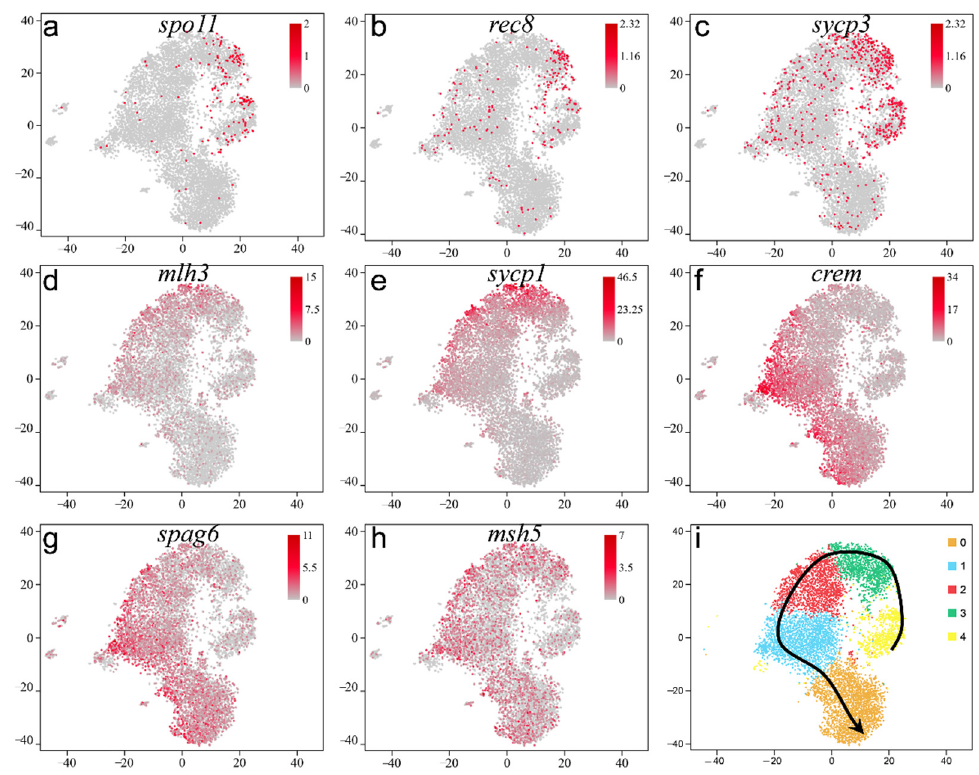
Figure 7. Developmental trajectory of male germ cells. ( a ) spo11 , ( b ) rec8 , ( c ) sycp3 , ( d ) mlh3 , ( e ) sycp1 , ( f ) crem , ( g ) spag6 , ( h ) msh5 , ( i ) the developmental trajectory of male germ cells (cluster 0–4). From cluster 0 to cluster 4, spermatogonia differentiates into sperm gradually. ( b − i ), meiosis-related genes located in all clusters visualized by t-SNE.